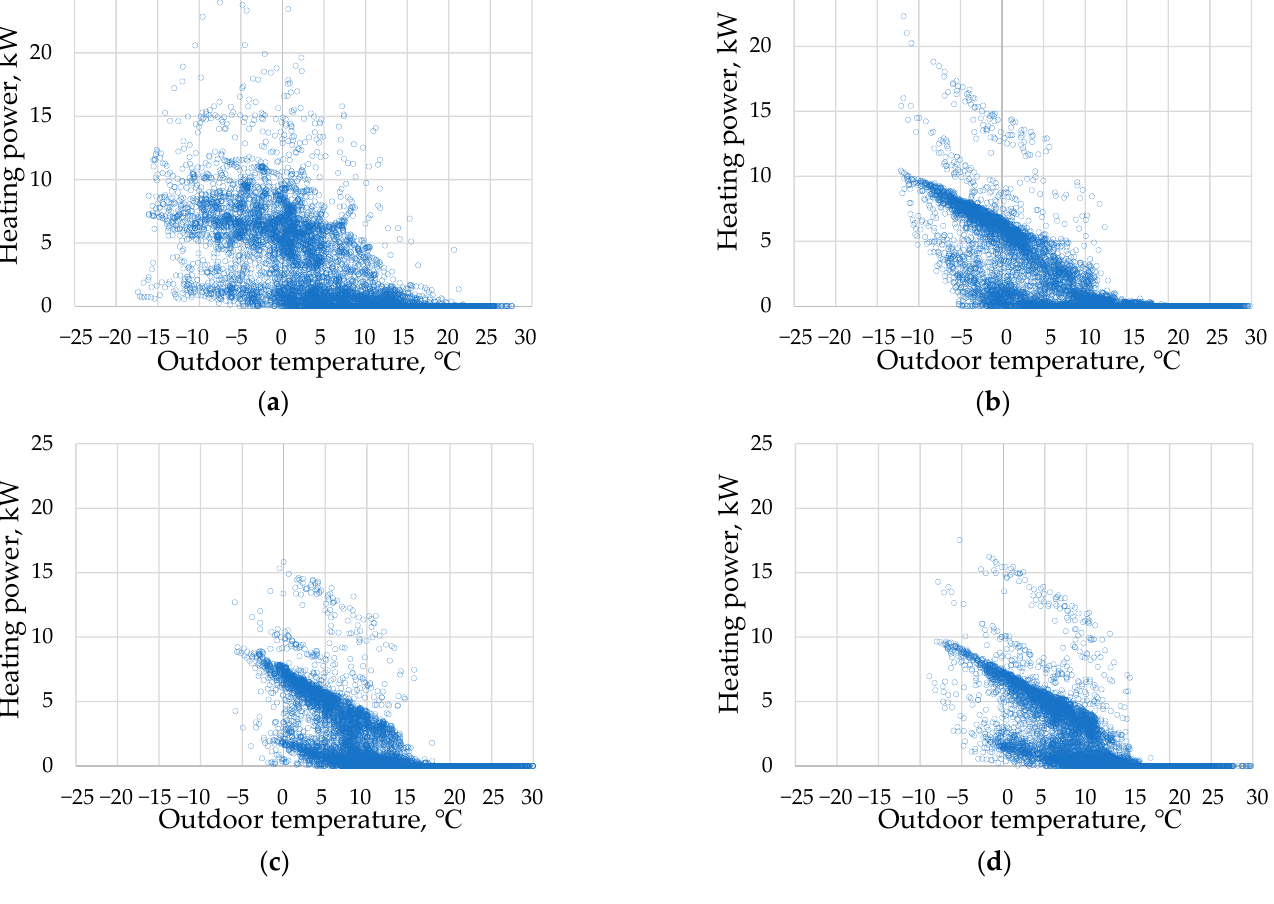
( d ) Figure 5. Base temperature of cooling degree day (CDD) for different climates ( a ) Tallinn, ( b ) Sapporo, ( c ) Paris, and ( d ) Brussels.